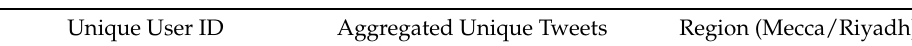
Table 3. Schema Used in Experiments.